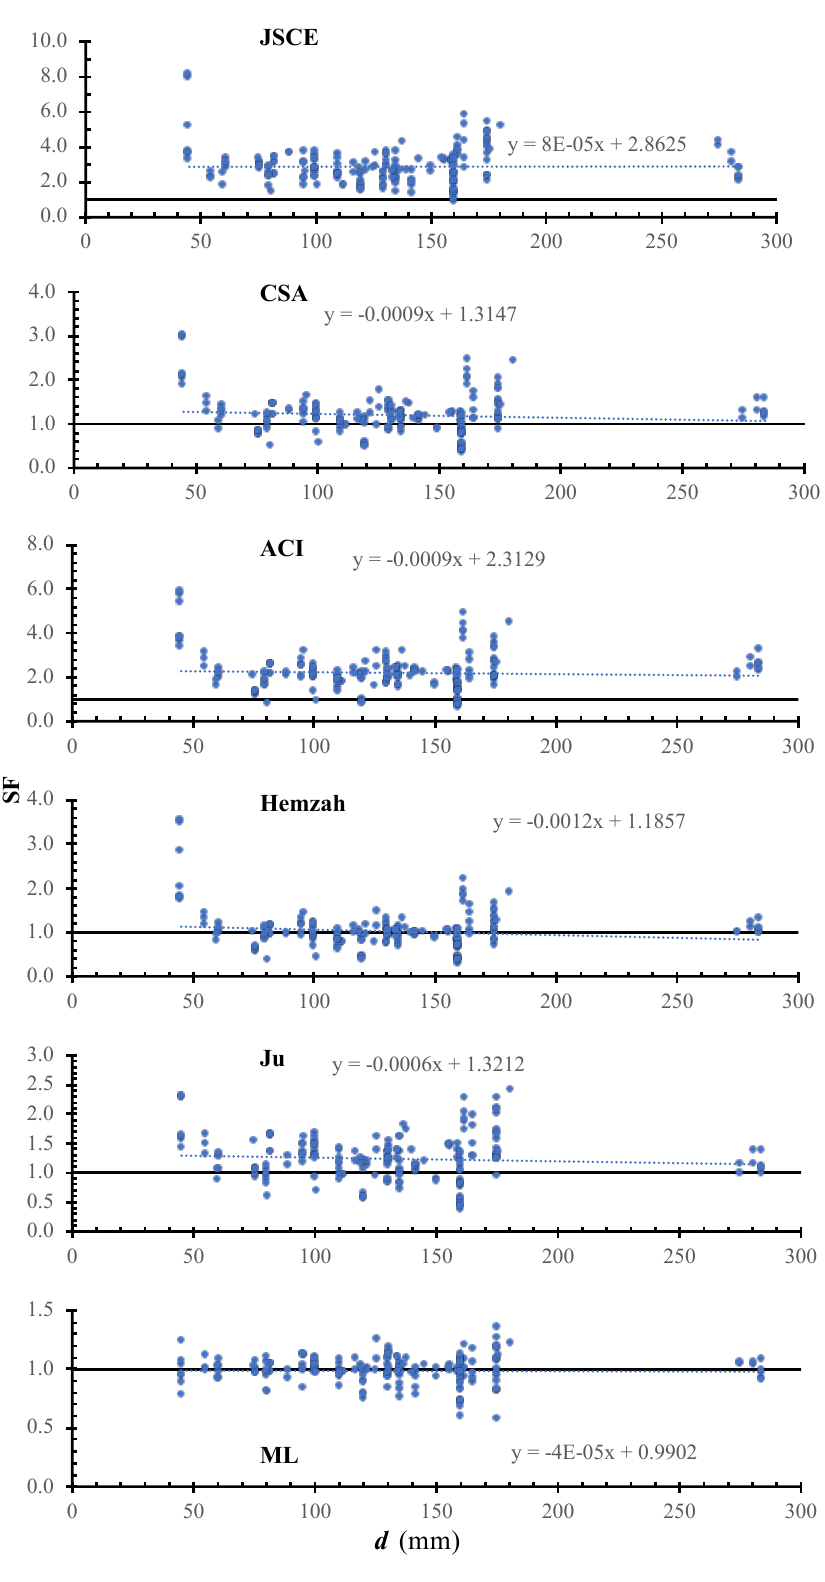
Figure 6. SF calculated using various models versus